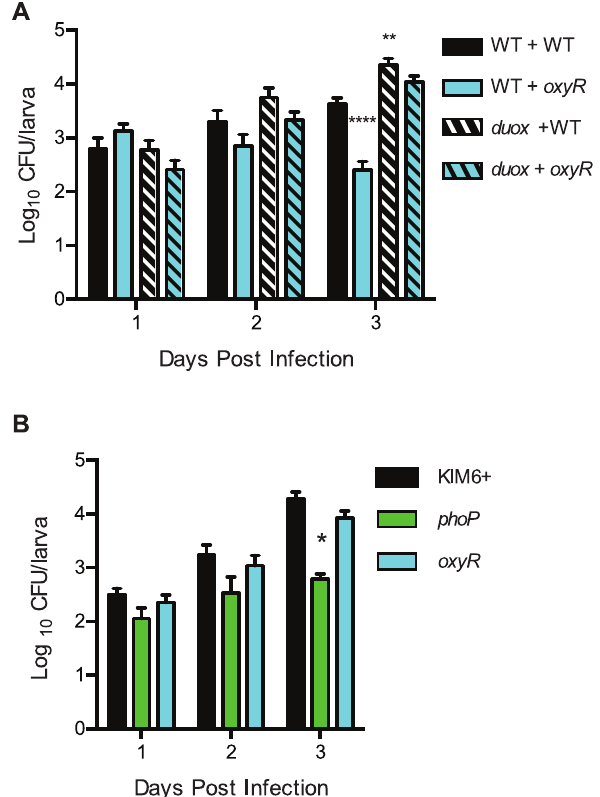
Fig 6. Host ROS production controls Y . pestis colonization. Wild type (WT) or Duox mutant Drosophila larvae were infected with WT or mutant Y . pestis strains, and bacterial loads per larvae were monitored over three days. (A) WT (solid bars) and Duox mutant (striped bars) fly strains were infected with WT KIM6+ (black) or the oxyR mutant (light blue). (B) Duox mutant flies were infected with WT KIM6+ (black), the phoP mutant (green), or the oxyR mutant (light blue). For both panels, infections were performed at least in triplicate (n (cid:1) 15 for each bar) and data were pooled. Means with standard error are shown. ANOVA with Dunnett's post-test was performed using KIM6+ infections of WT flies as the control and comparisons were made for each day. * P < 0.05, ** P < 0.01, **** P <